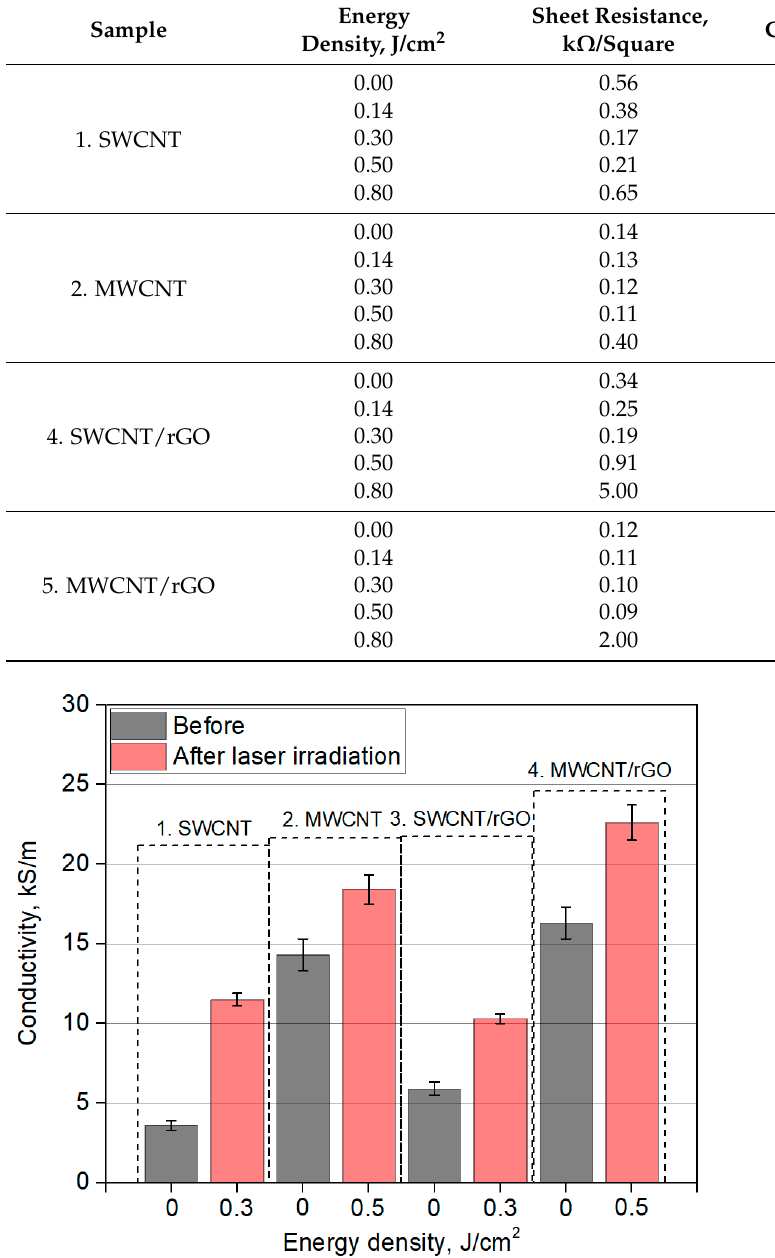
Figure 9. Electrical conductivity of films before (black columns) and after (red columns) laser irradiation with energy density 0.3 J/cm 2 for SWCNT and SWCNT/rGO, 0.5 J/cm 2 for MWCNT and MWCNT/rGO.